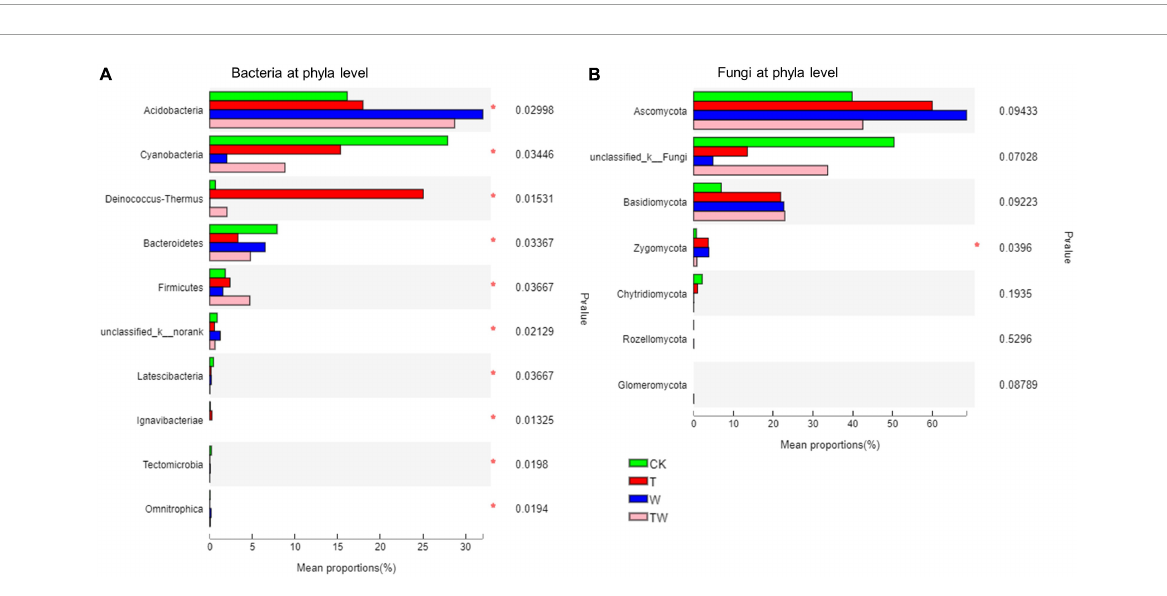
38.86% for bacteria and fungi, respectively ( Figure 2 ).